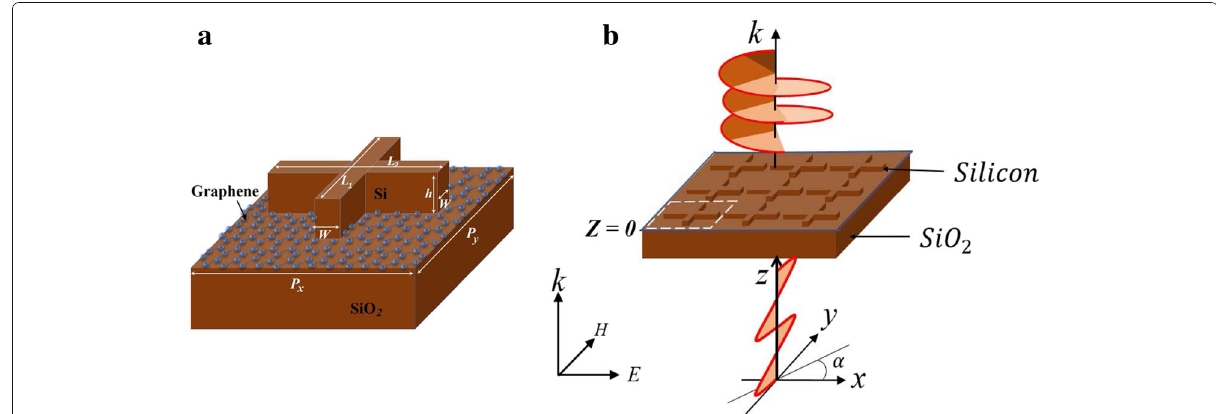
Fig. 1 Schematic illustrations. a. Unit cell dimensions: L 1 = 450 nm, L 2 = 370 nm, h = 110 nm, W = 60 nm, P x = 600 nm, and P y = 560 nm. b. Incident linearly polarized light at an angle of polarization, α , converted to circularly polarized light through the